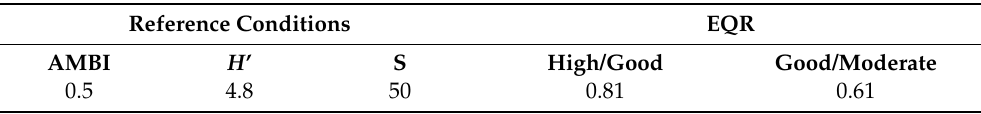
Table 1. Reference conditions and the type specific EQR obtained from the 2016–2018 Regional Agency for Environmental Protection